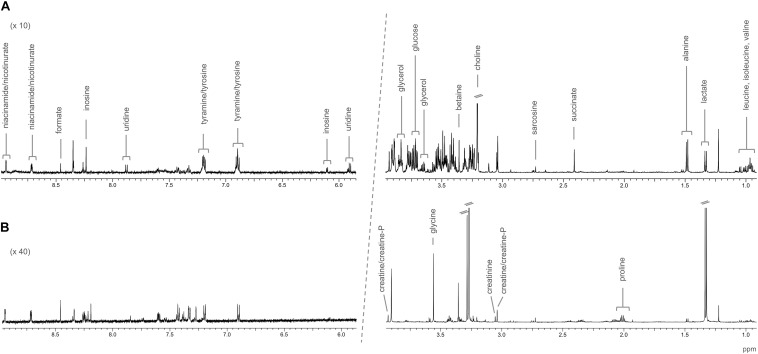
Representative NMR spectra of barramundi (L. calcarifer), with the assignments of identified metabolites; (A) CPMG spectrum of the aqueous fraction of liver; and (B) 1D 1H spectrum of the aqueous fraction of muscle.